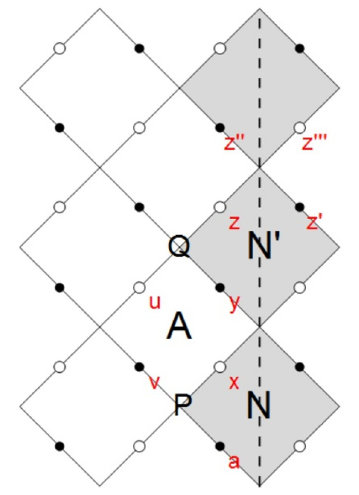
Figure 24 . Boundary conditions. Vertical and horizontal directions are τ and σ , respectively. Kink worldlines are shown as solid black lines. Vertical dashed line indicates the location where the worldsheet touches the AdS boundary. P, Q are spacetime points, while A, N , and N 0 are normal 3 vectors. Red lowercase letters label the discrete a field at different ij